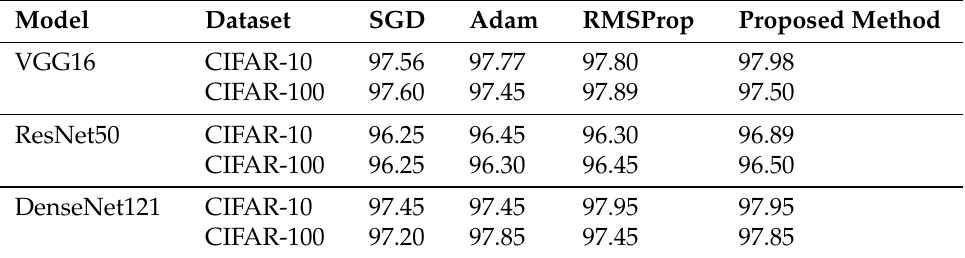
Table 4. Training accuracy for various machine learning models.